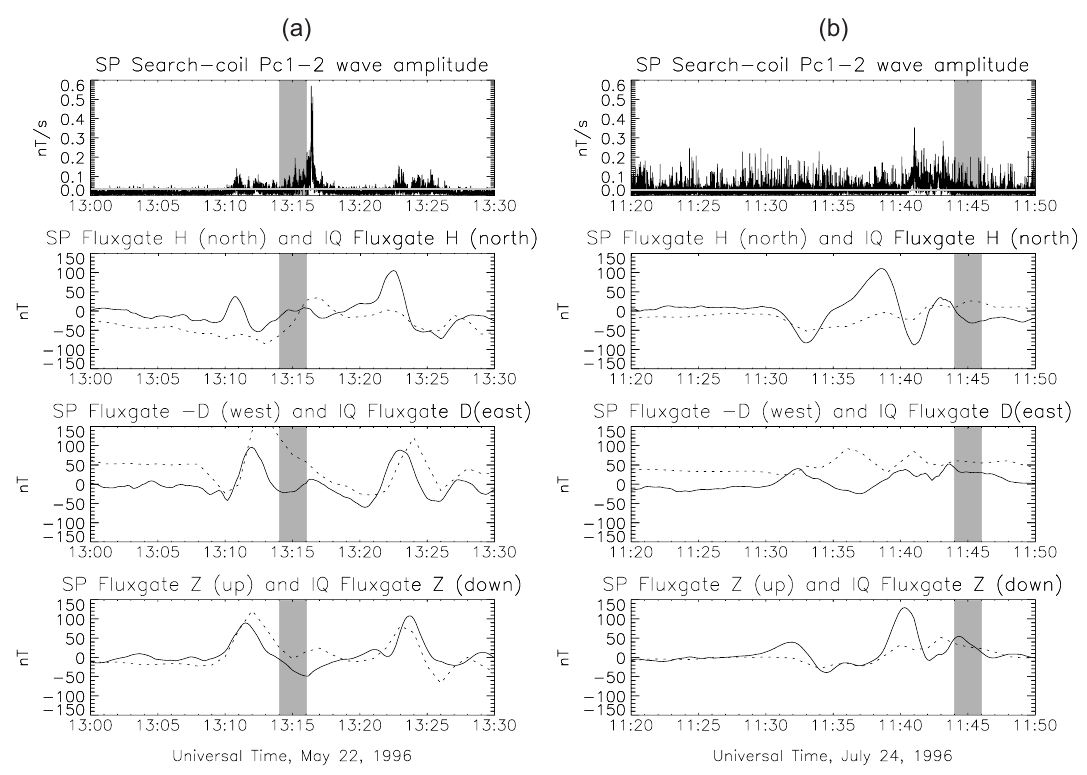
Fig. 6. Pc1–2 activities and magnetic impulse events observed by conjugate magnetometers. The top panels show the amplitude of the band-pass filtered time series in the Pc1–2 range (0.1–5.0Hz) using 10Hz sampling search-coil magnetometer data at the South Pole (SP) in Antarctica in a (a) 22 May event and (b) 24 July event, respectively. The standard deviation of 1 σ is plotted with gray horizontal lines. The bottom three panels show the three components of fluxgate magnetometer data at SP. Conjugate magnetometer data at Iqaluit (IQ) are also plotted with dotted lines. Shaded time intervals correspond to the observation period of extremely broad